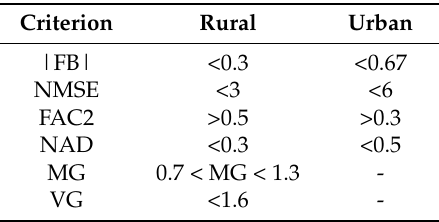
Table 2. The bounds of acceptable performance for dispersion models as proposed by Hanna et al. [21], Hanna and Chang [22] and Chang and Hanna [23].